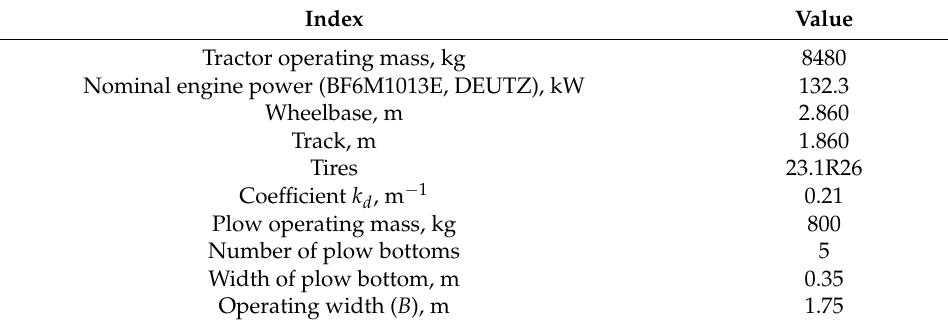
Figure 3. Tractor HTZ-17021 with five-furrow plow. Table 1. Main technical characteristics of the plowing